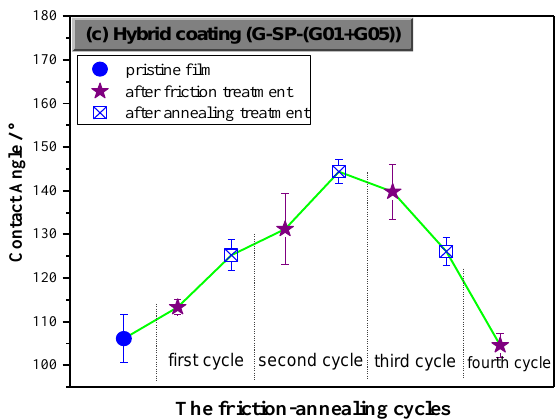
Figure 7. Hydrophobicity of the hybrid coating with 2 wt.% G-SP-(G01 + G05) addition in four friction-annealing cycles.